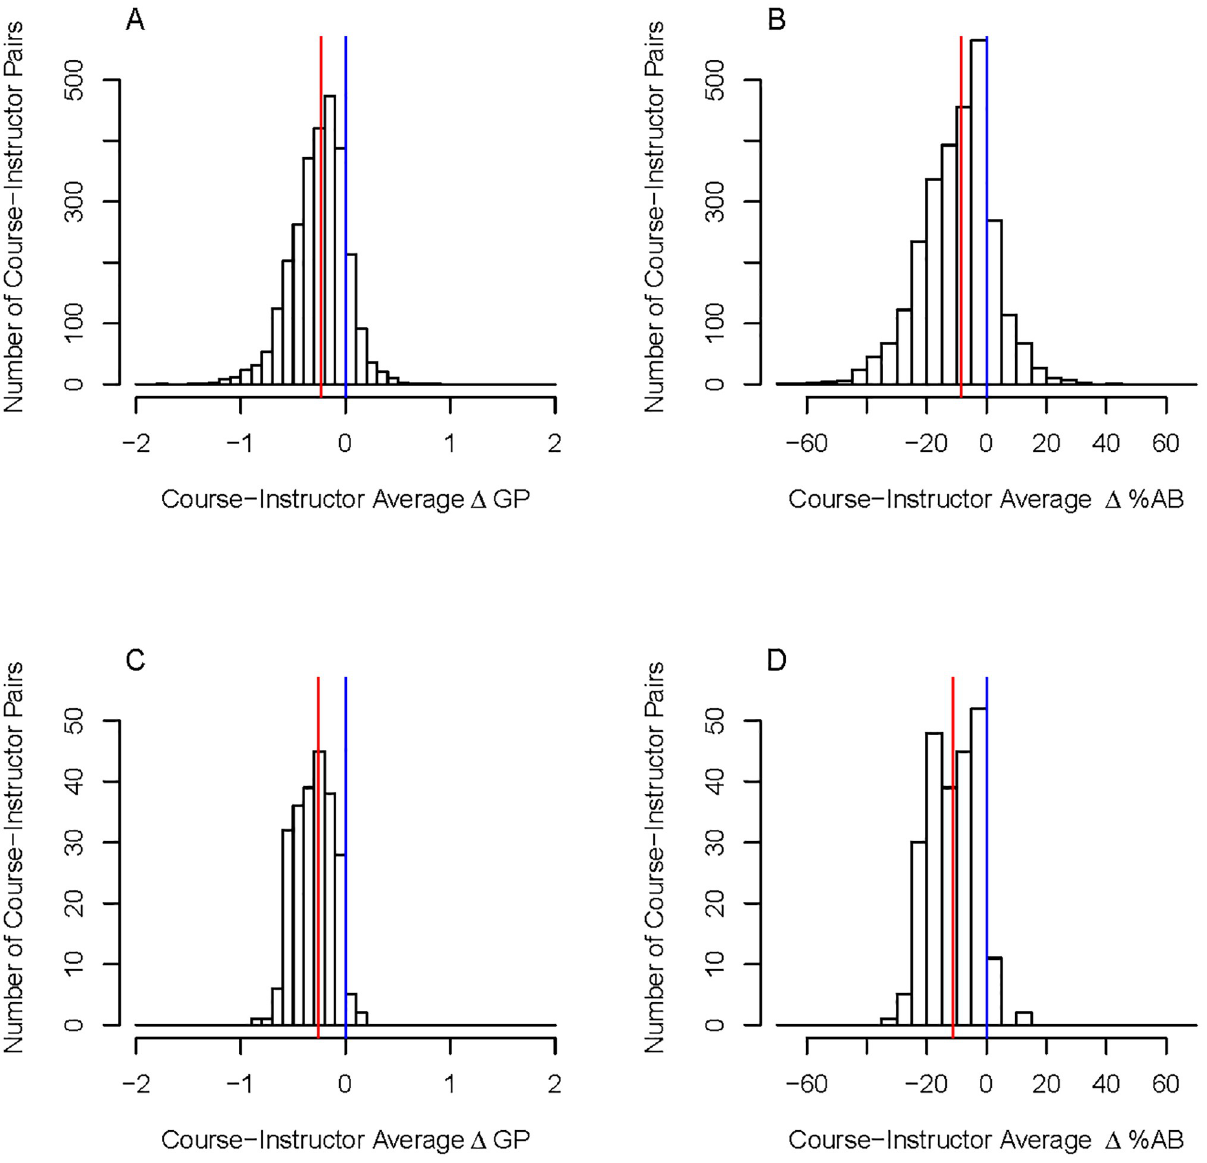
Fig 1. Histograms of the opportunity gaps between PEERs and non-PEERs per course section at the instructor level (course-instructor pairs). Histogram of the course-instructor pairs average grade point difference ( Δ GP) and the average difference in the percent of A and B grades given to PEERs and non-PEERs ( Δ %AB). The red line represents the median on each plot and the blue line represents no difference between PEERs and non- PEERs. (A) and (B) include all 2,752 course-instructor pairs. The median course-instructor average for Δ GP is -0.23 and for Δ %AB is -9%. (C) and (D) include course-instructor pairs that had at least 4 occurrences (233 such pairs). For these pairs with at least 4 occurrences, the median course-instructor average for Δ GP is -0.30 and for Δ %AB is